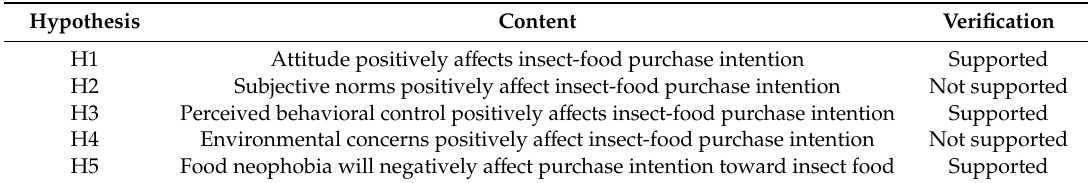
Table 4. Summary of hypothesis